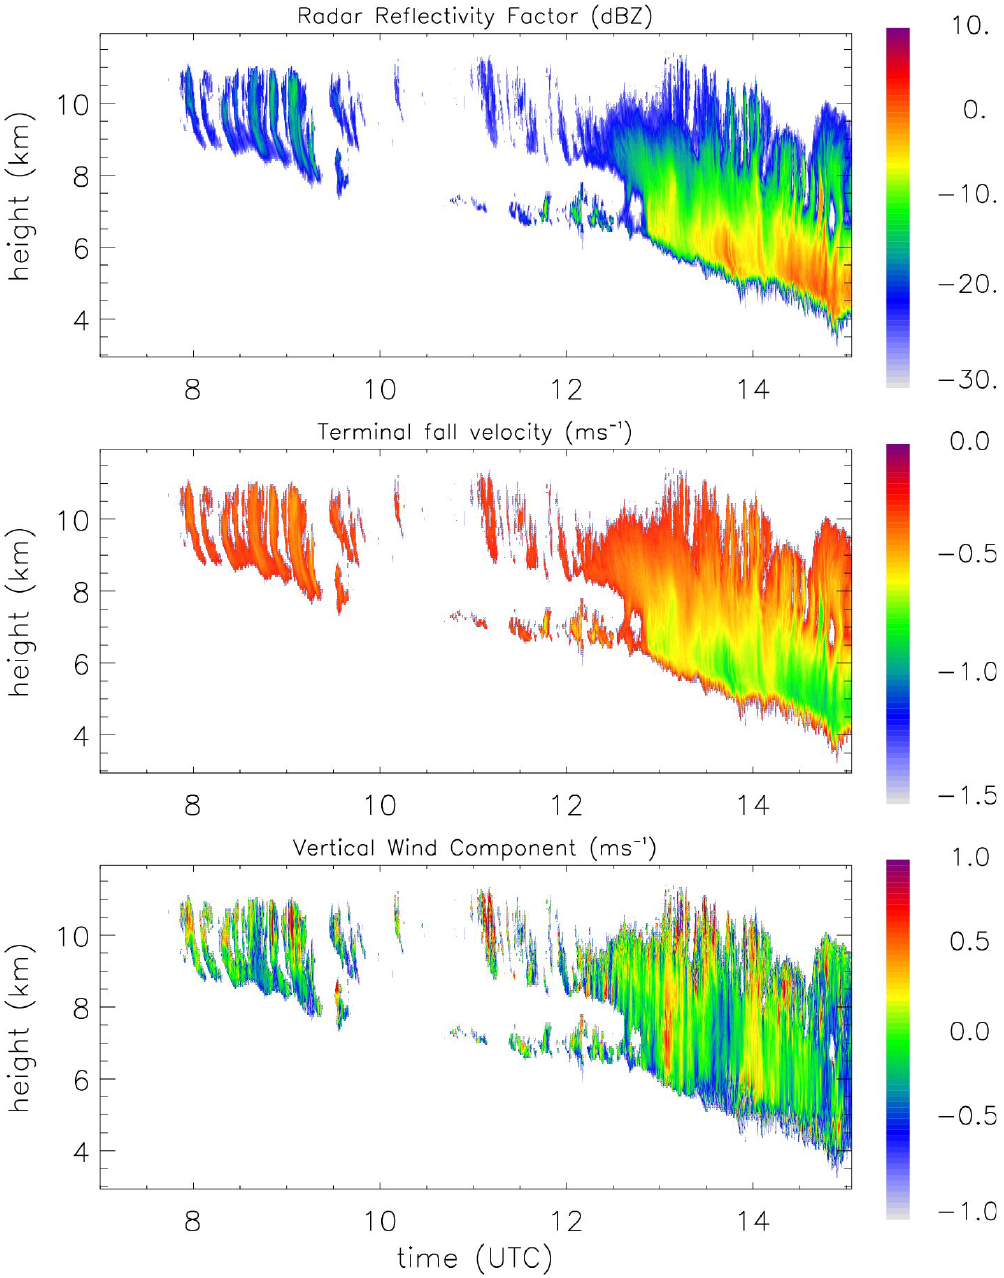
Fig. 7. Dynamical properties of the cloud layers observed at SIRTA on 1 April 2003: (a) RASTA radar reflectivity (dBZ), (b) particle terminal fall velocity (ms − 1 ) and (c) air vertical velocity (ms − 1